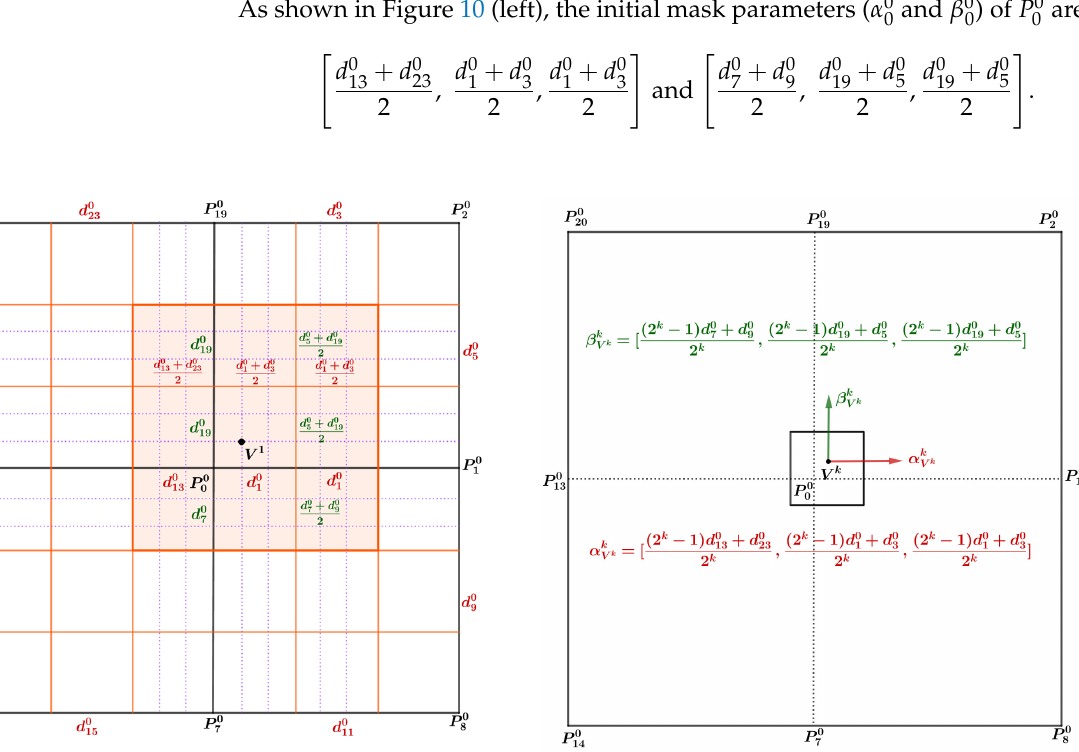
Figure 10. Left: updating of the mask parameters around the vertex after two subdivisions. Right: the mask parameters around the vertex after 𝑘